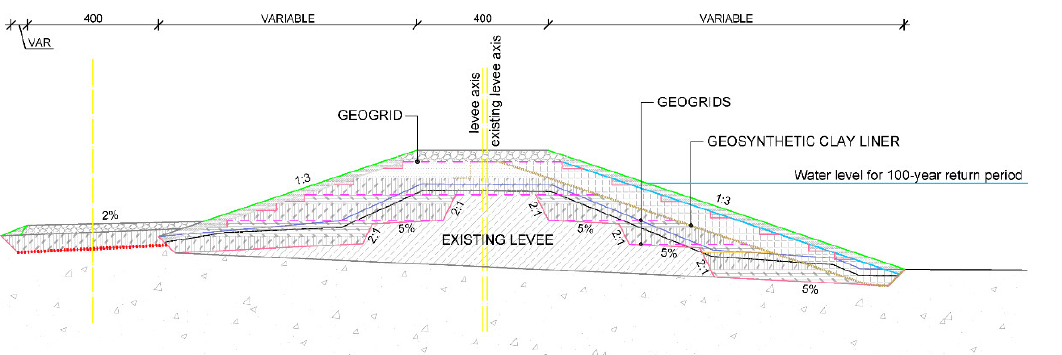
Figure 6. Levee cross section.